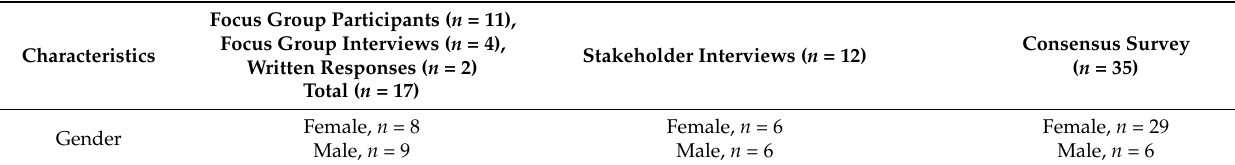
Table 1. Description of participants in Focus Groups and